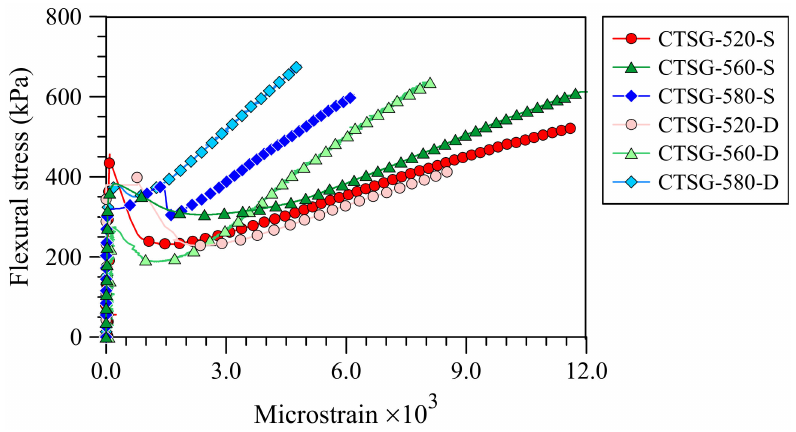
Figure 6. Flexural stress - strain curves.